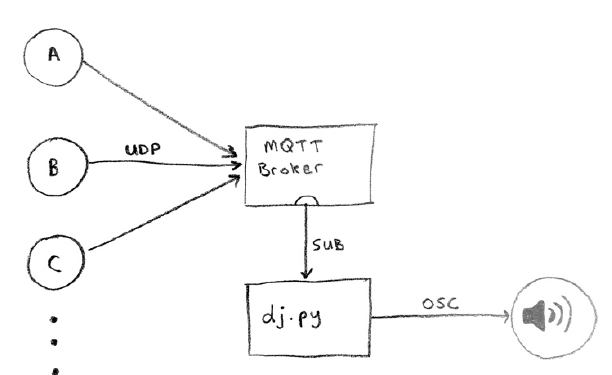
Fig. 1. Message flow architecture in Subtlenoise where A, B, C are collection agents which send raw messages to a central broker. The python script dj.py transform these messages into OSC commands suitable for audio